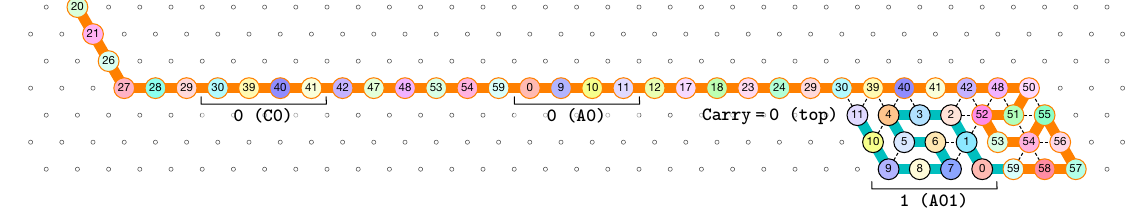
Figure 6. The folding of the first module, A : starting with a carry 1, encoded by the position of the first bead (on the bottom row), this module “reads” a 0 from the seed by binding to the seed, and folds into A01 , encoding a 1 with no carry propagation, as encoded by the position of the last bead (on the top row of the